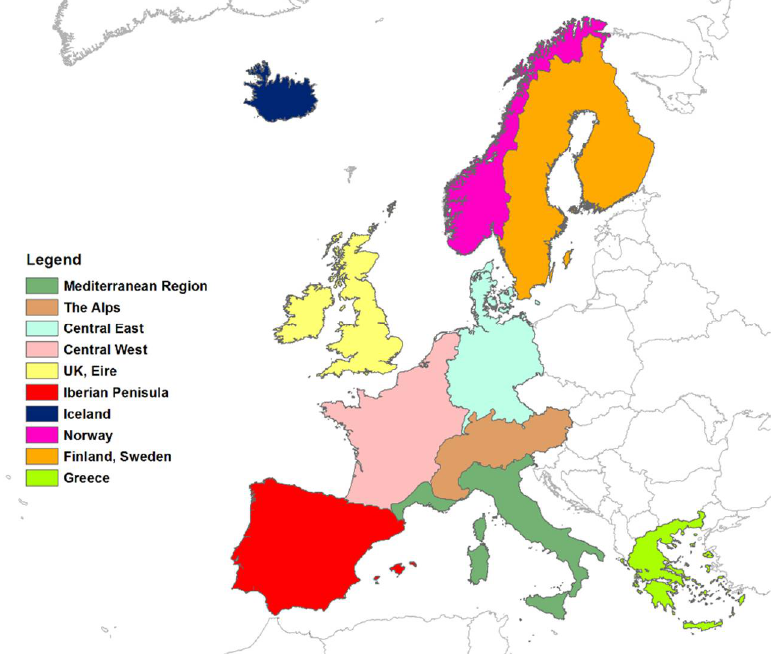
Figure 3. Climatic regions defined in Annex C of EN1991-1-3, based on the results of the European Snow Load Research Project (ESLRP).